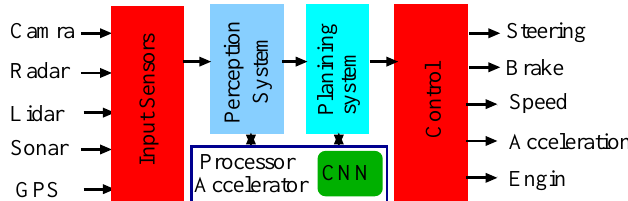
Figure 1. Control circuit, input sensor and output for the autonomous vehicles.